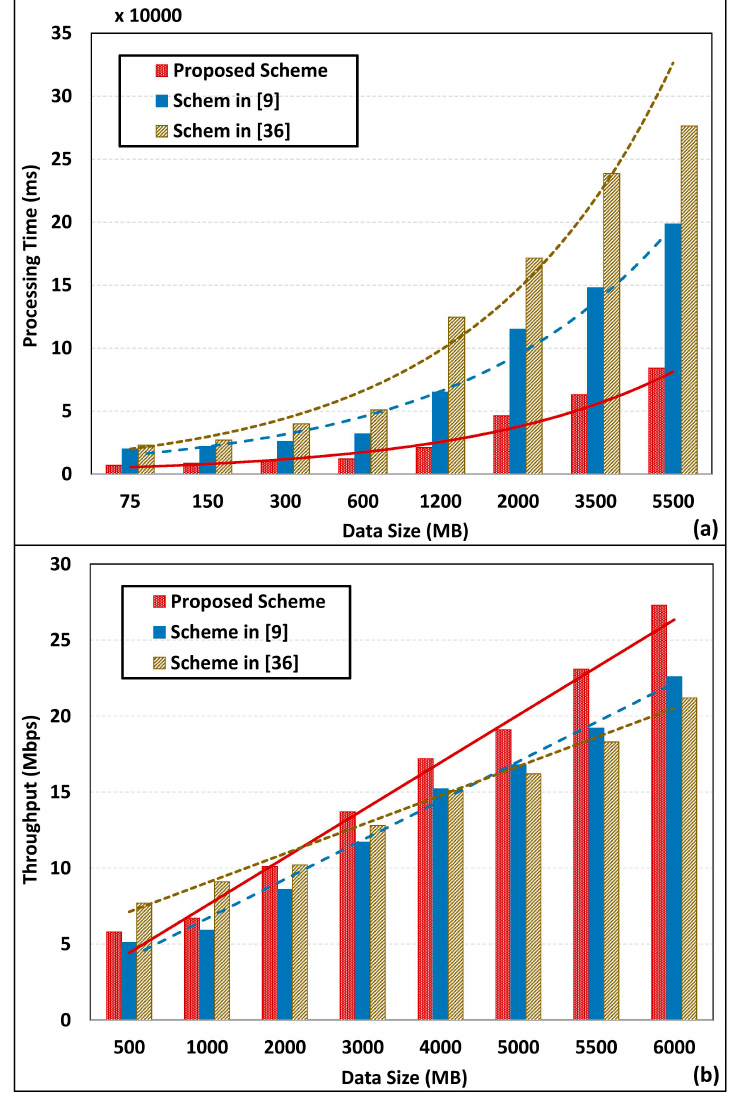
Figure 12. Performance comparison of filtered Spark analysis with existing schemes. ( a ) Processing time analysis with data growth, ( b ) Throughput analysis with data growth.